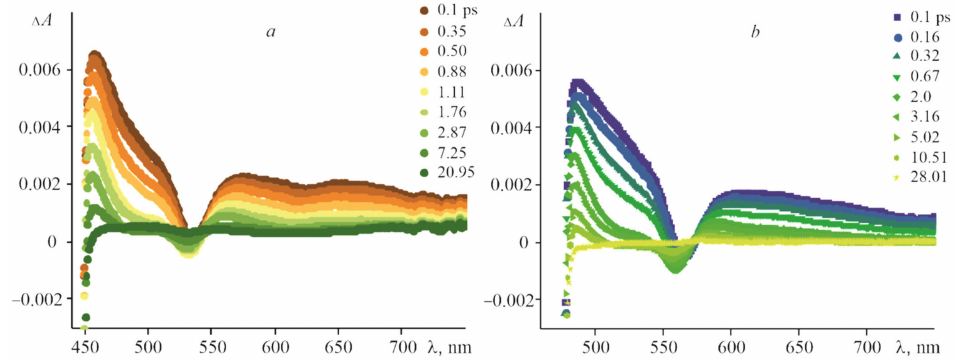
Figure 12. The FTA spectra at various time delays for (PyC 60 ) 2 CoTTP ( a ) and (C 60 ) 2 CoTTP ( b ) in toluene following the 435 nm laser